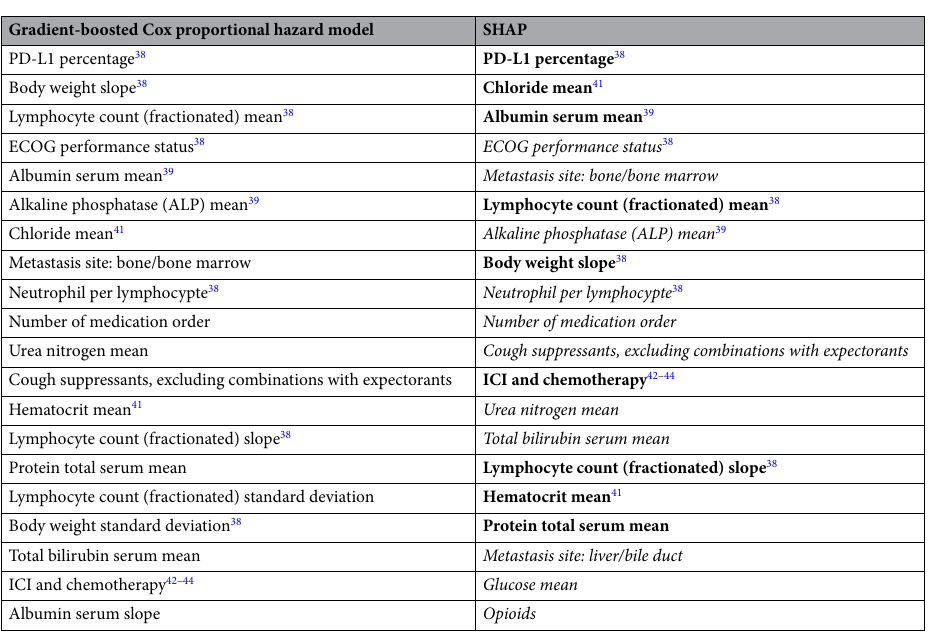
Table 4. Top 20 predictors of progression-free survival identified by the gradient-boosted Cox proportional hazard model and SHAP values. SHAP indicates directionality of the importance (bold: higher values indicative of better progression-free survival; italics: lower values indicative of better progression-free survival). ECOG, Eastern Cooperative Oncology Group; PD-L1, programmed cell death-ligand 1; SHAP, SHapley Additive